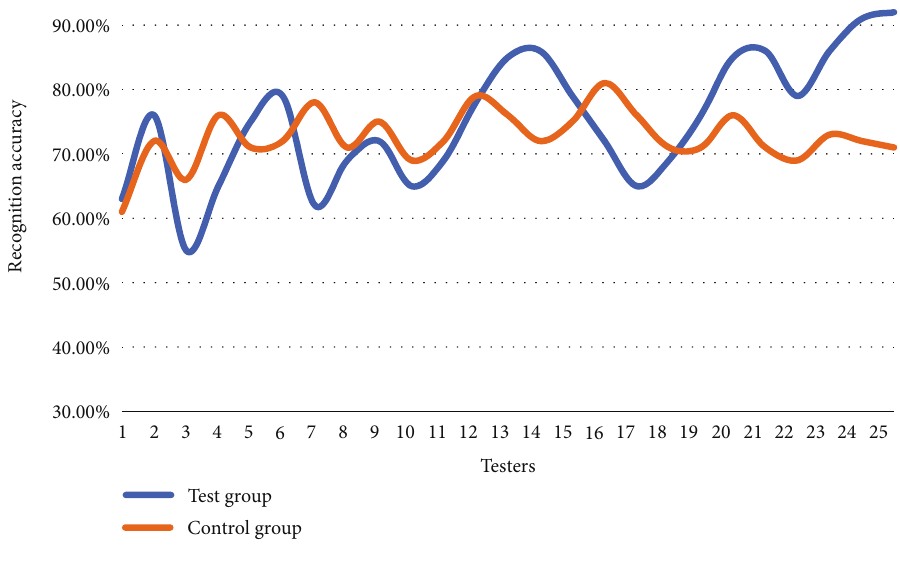
Figure 6: Facial recognition under occlusion. Table 1: Facial recognition under the condition of high degree of face